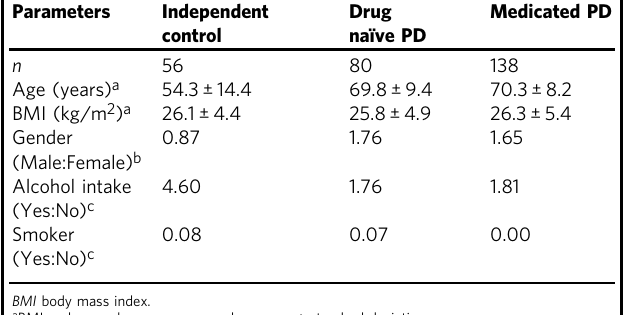
classi fi cation modelling and statistical